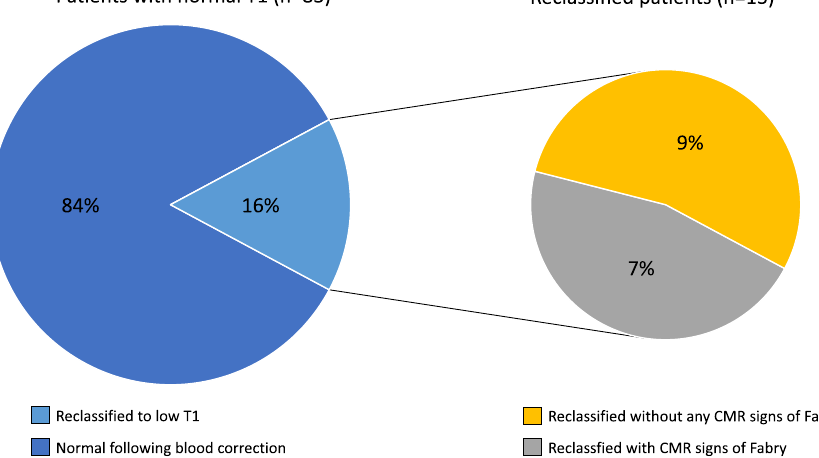
Figure 2. The reclassification of patients with normal myocardial native T1 prior to blood-correction. Following blood-correction, 84% remained normal (blue) whereas 13 (16%) were reclassified as having low myocardial native T1 (light blue). Of these 13, 7 (54%, yellow) had no other CMR signs of Fabry disease (neither LGE or LVH). Displayed in grey are reclassified patients (n = 6, 46%) with other CMR signs of Fabry (either LGE or